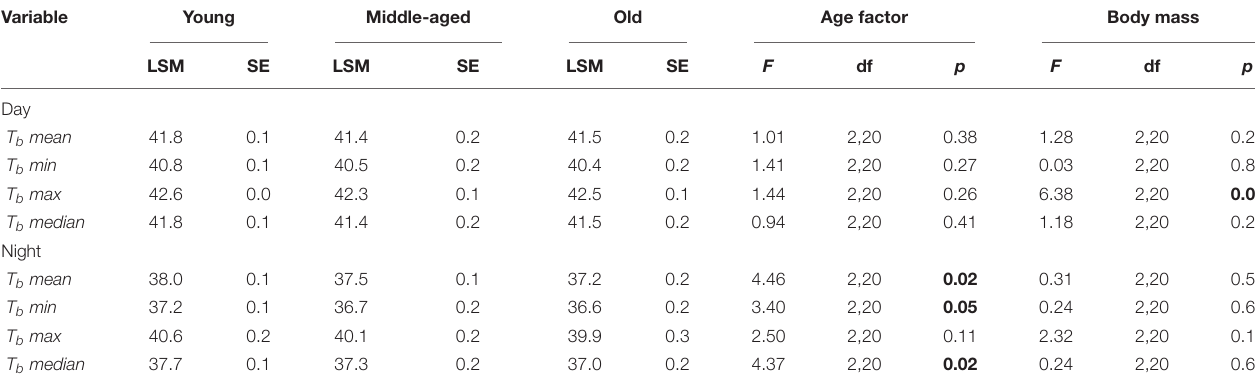
The non-enzymatic antioxidant capacity in